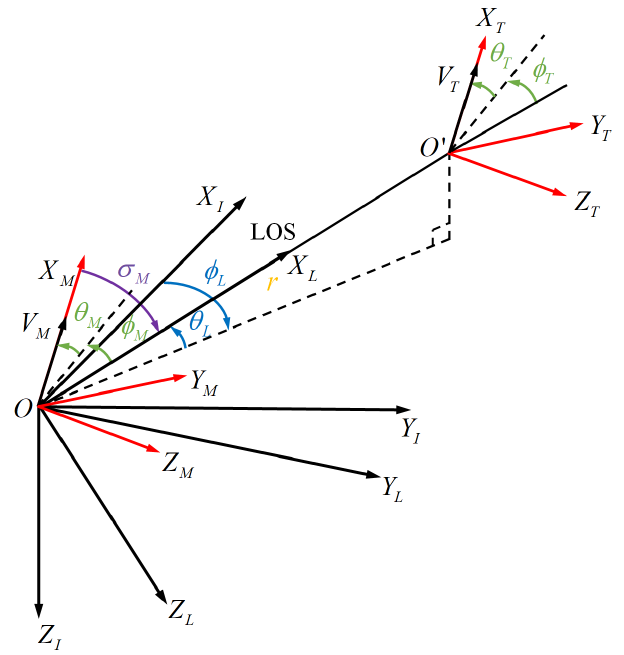
Figure 1. Munition-target engagement geometry in a 3-D